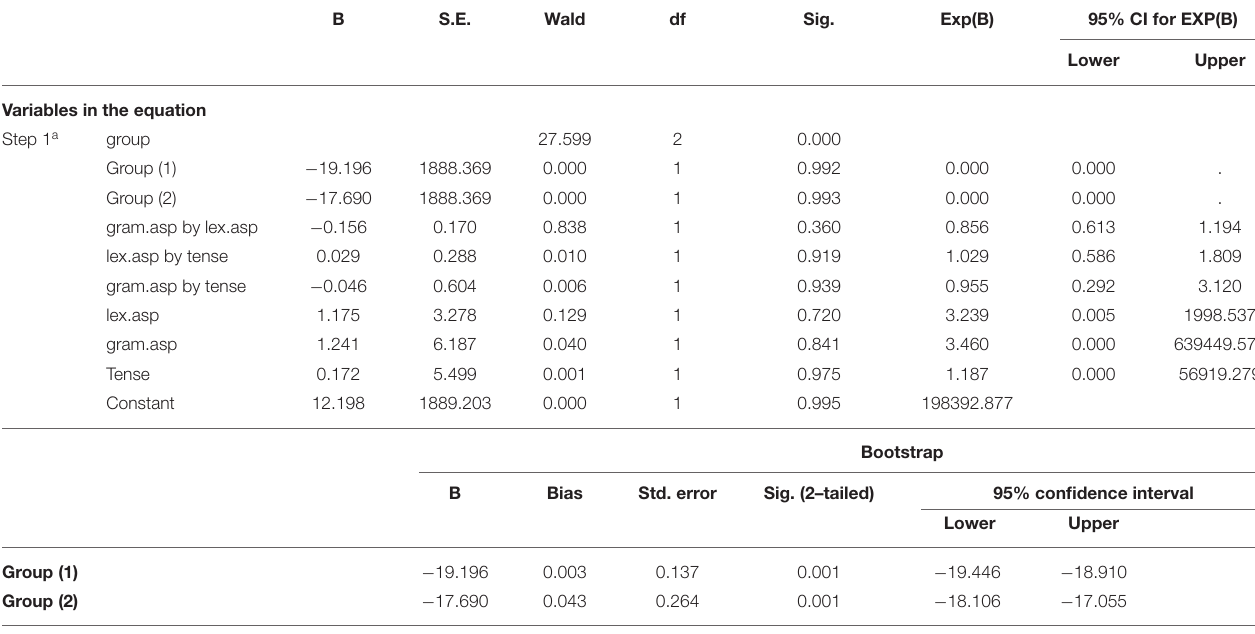
TABLE 5 | Outcome of logistic regression for sentence completion